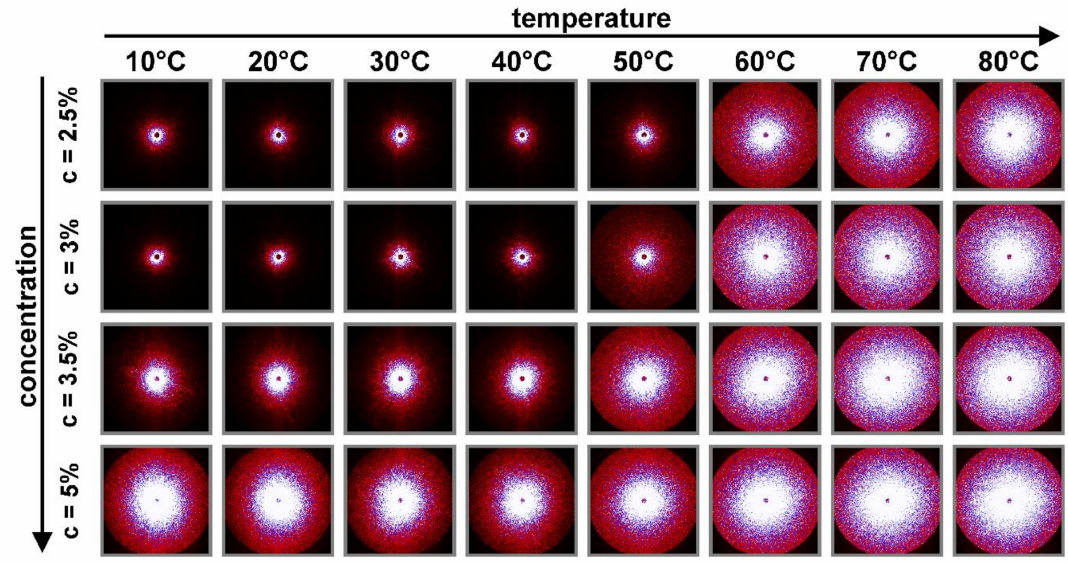
Figure 6. Comparison of the light scattering patterns obtained for different polymer concentrations and